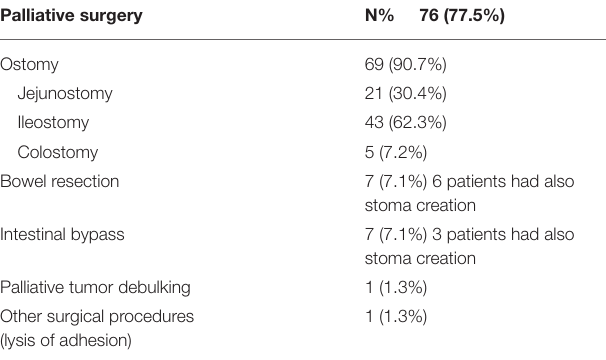
TABLE 2 | Palliative surgical procedures.